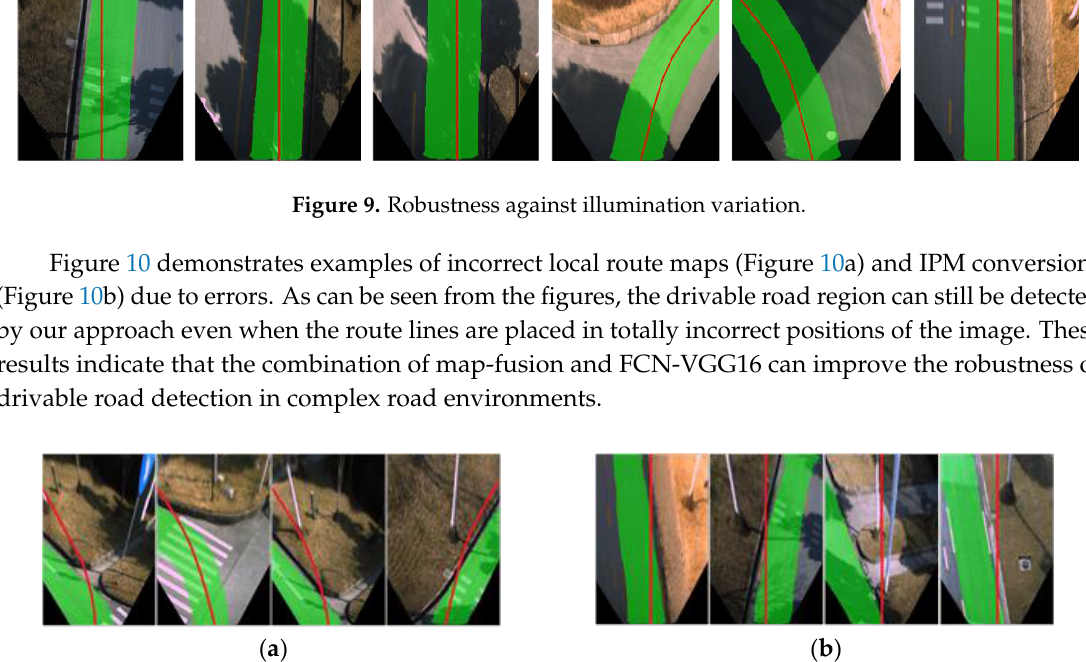
local map extracting deviation; ( b ) Detection results in the presence of IPM errors.